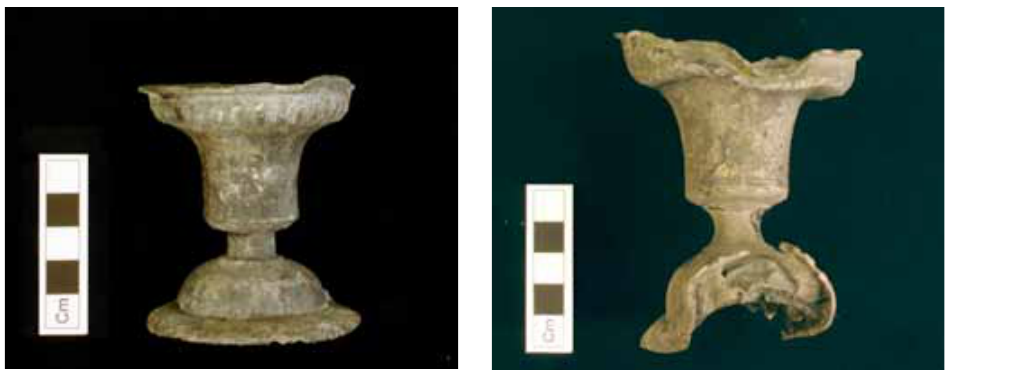
Tin-alloy salt stand (14) Tin-alloy salt stand (86.1)